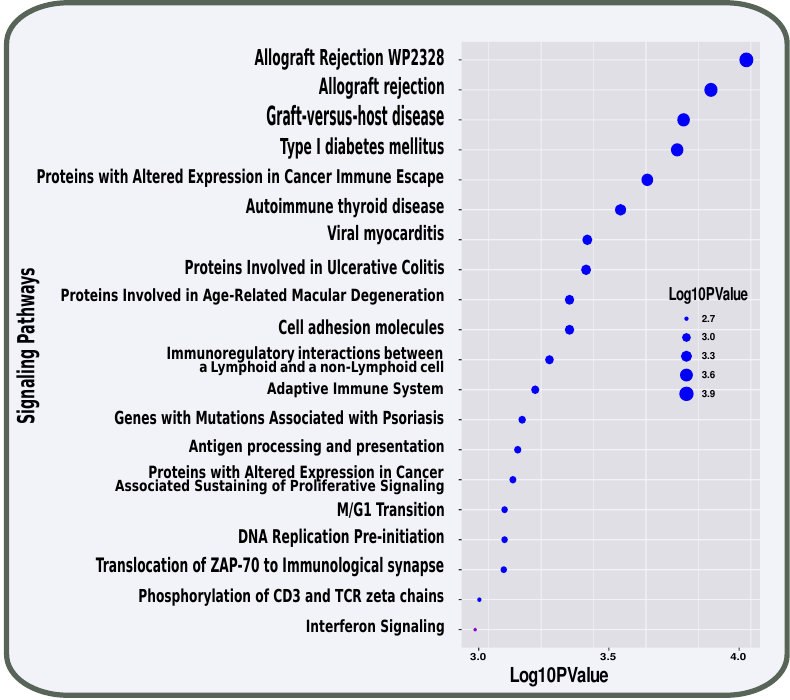
Figure 4. Top 20 pathways are represented using a bubble plot that are associated with both conditions in transcriptomic analysis.